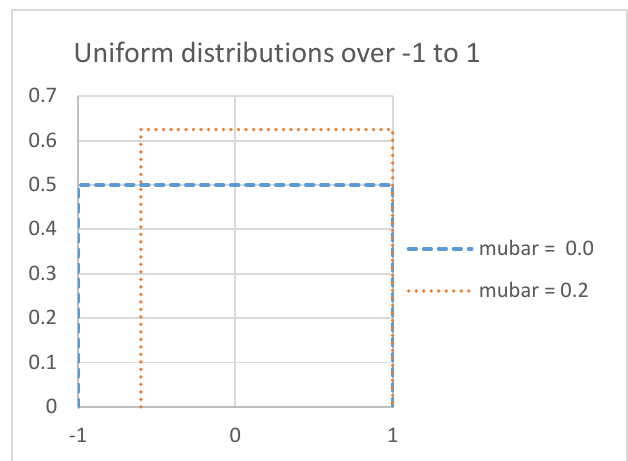
Uniform distributions over -1 to 1